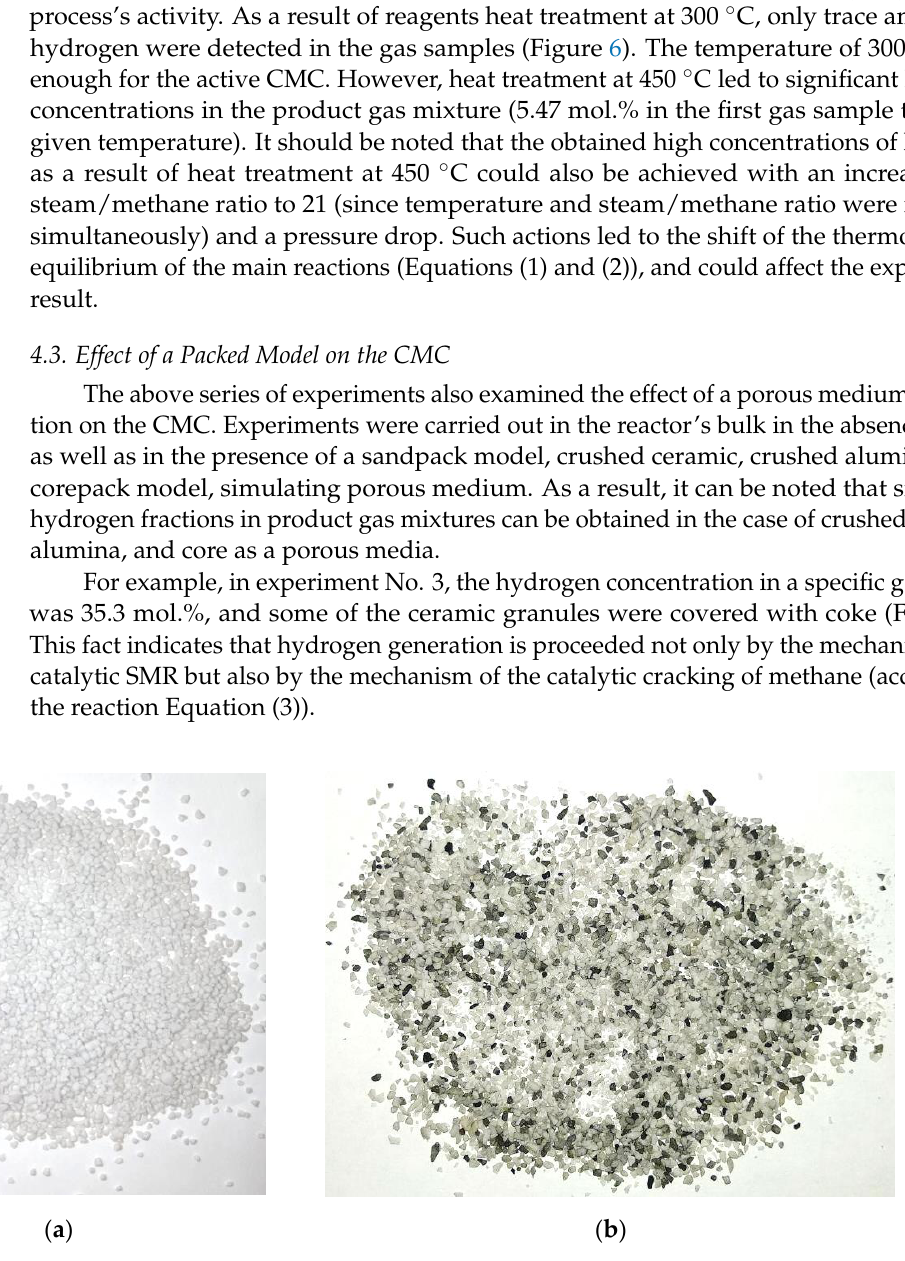
Figure 9. ( a ) The appearance of the ceramic granules of the packed model before the experiment No. 3 and ( b ) after the experiment No. 3.